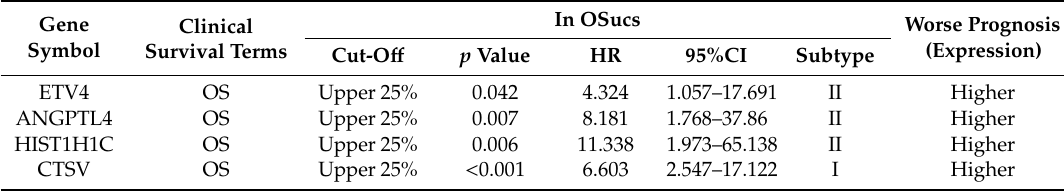
Table 3. Evaluation of potential predictors for UCS survival in